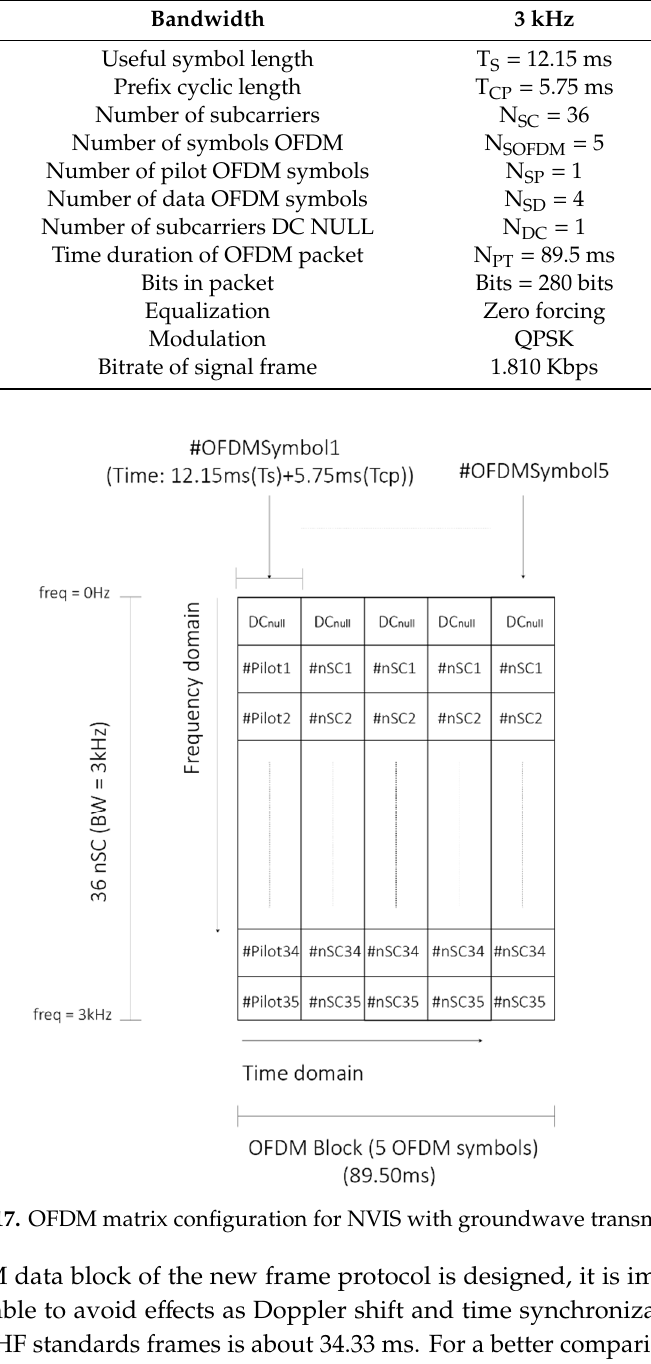
Table 3. OFDM configuration for NVIS with groundwave transmission.